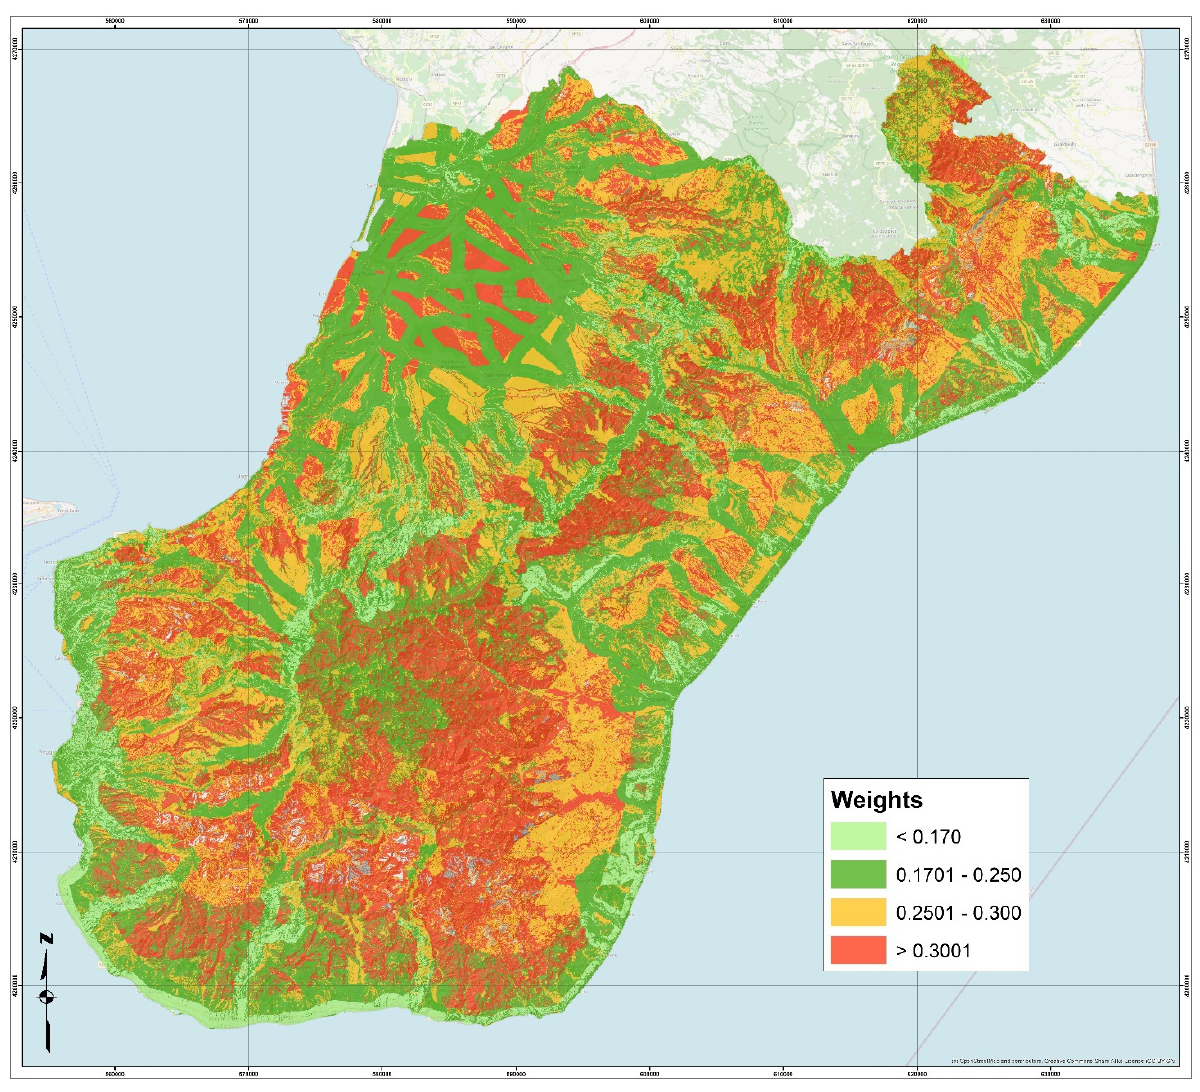
Figure 2. Landslides susceptibility map.